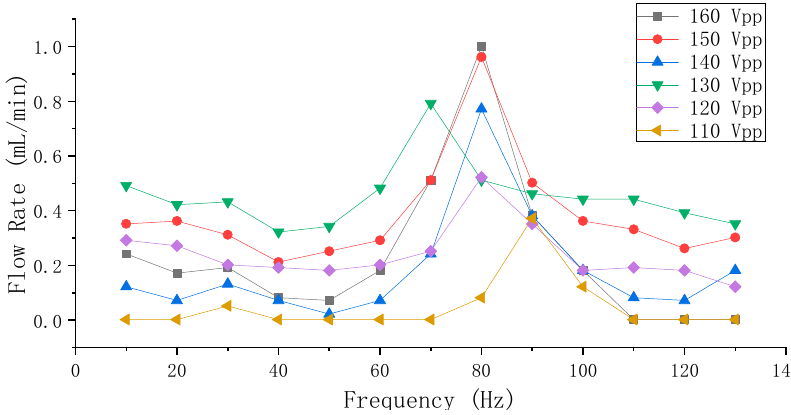
Figure 9. The flow rate measuring results of Group B PZT pumps.